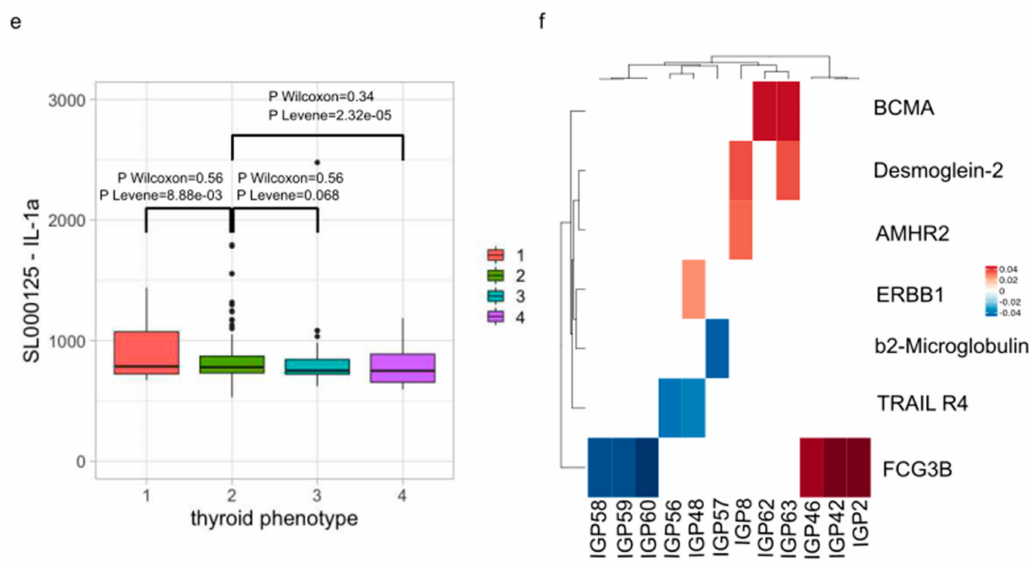
Figure 4. Association of circulating protein abundances with thyroid diseases and with AITD-IgG N-glycan structures. ( a ) 1,113 circulating proteins were arranged in two dimensions based on the similarity of their secretion profiles in the serum by the dimensionality reduction technique UMAP [72] using R package umapr [73]. ( b ) Correlation of log10-transformed TSH measurements between two clinical FDA approved clinical immunoassays (Roche and Abbott) and SOMAscan assay in 217 individuals (122 using Roche immunoassay and 95 using Abbott immunoassay). ( c ) Box plot of the level of circulating TSH measured by SOMAscan assay in the serum according to the group of thyroid status. ( d ) Box plot of the level of circulating Caspase-2 measured by SOMAscan assay in the serum according to the group of TSH. ( e ) Box plot of the level of circulating IL-1 α measured by SOMAscan assay. An extreme outlier sample in the group 4 with an IL-1 α of 250,000 mg / mL was discarded for the analysis. ( f ) Heatmap of circulating protein abundances associated with AITD-IgG N-glycan